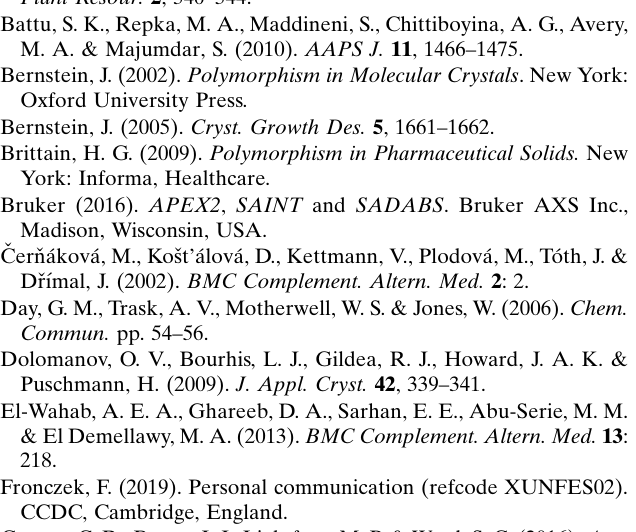
Table 3 Experimental details. Crystal data Chemical